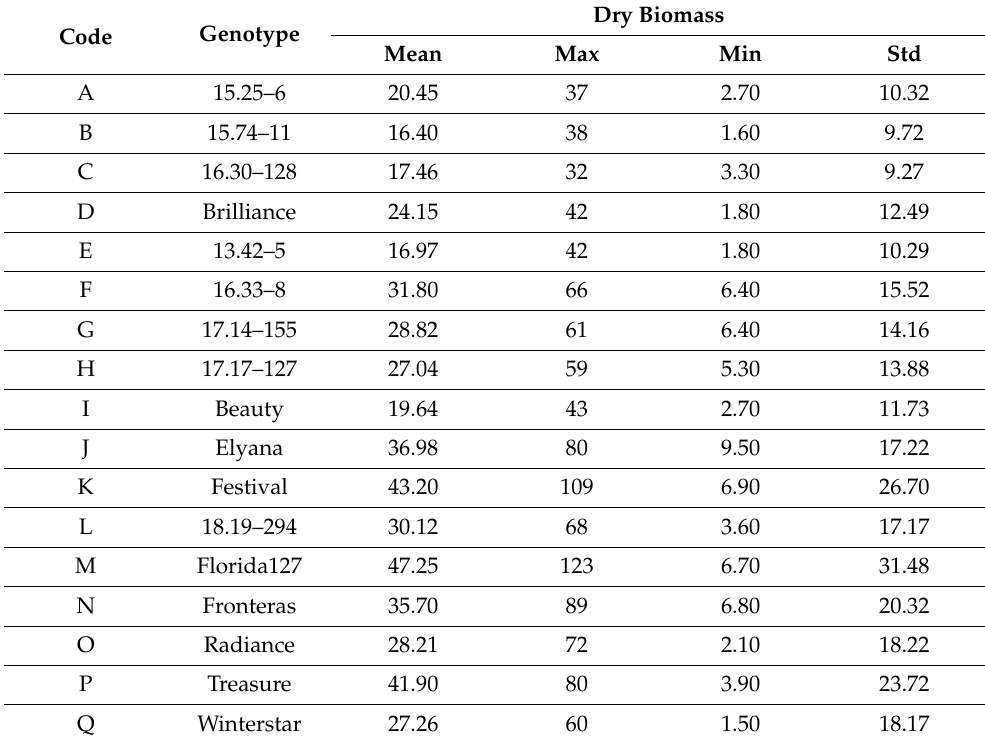
area. The UAV flew at an altitude of 15 m above the ground, with a speed of 2 m/s, cap- turing images with more than 70% overlap and approximately 1-cm raw spatial resolu- tion. The MicaSense multispectral camera contained five spectral bands: blue (475 nm, 20 nm bandwidth), green (560 nm, 20 nm bandwidth), red (668 nm, 10 nm bandwidth), near-